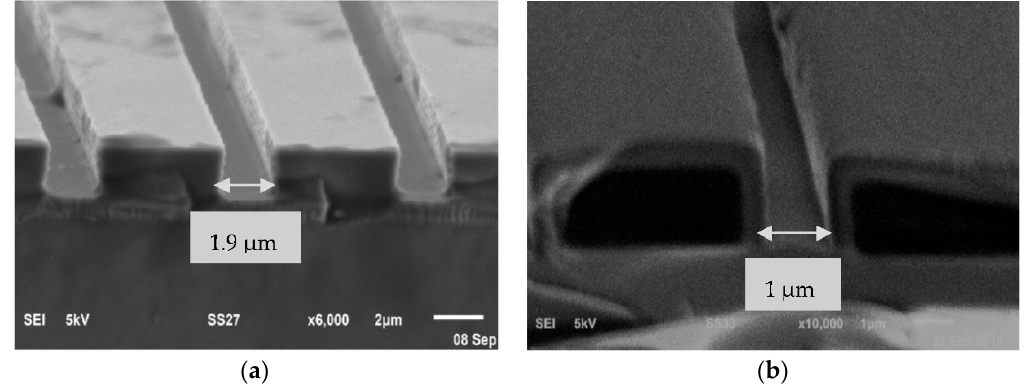
Figure 9. ( a ) Silicon microchannel before oxidation process; ( b ) SiO 2 microchannel after 12 h thermal dry oxidation at 1040 °C.